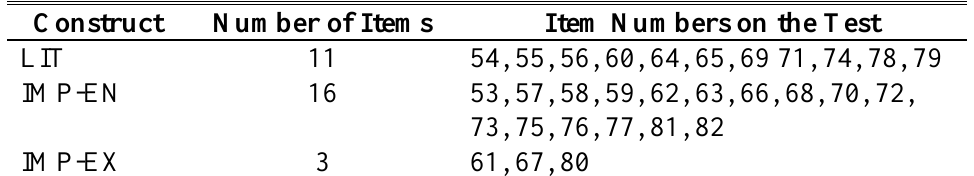
Original Taxonomy of the CEP Reading